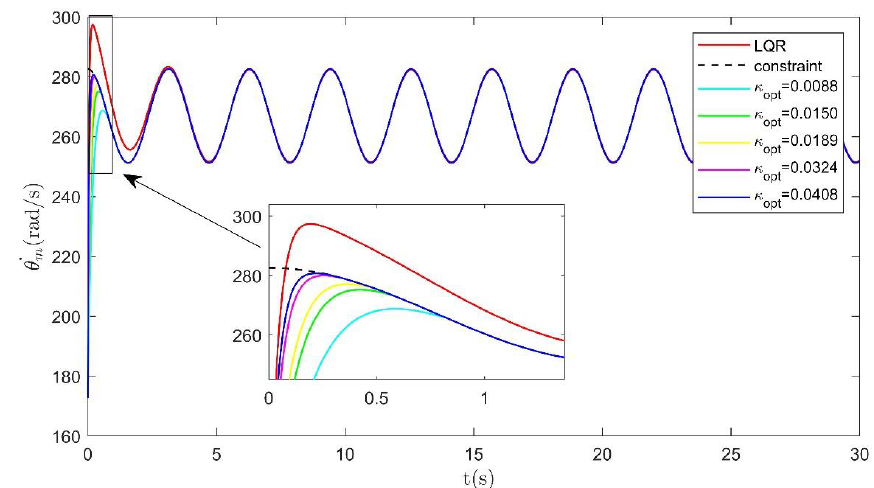
Figure 7. The sinusoidal tracking speed curve of the electric tail reduction system.